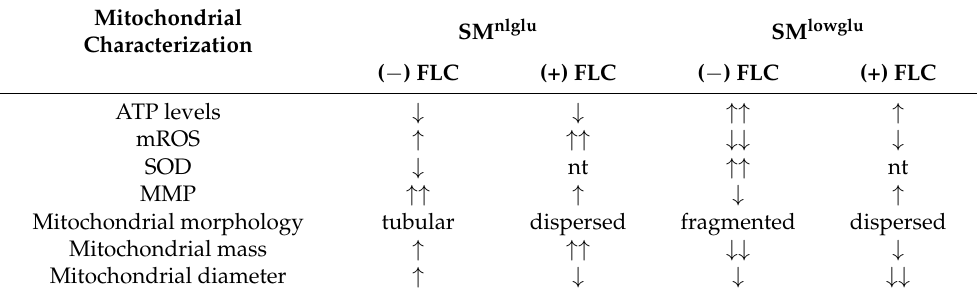
Figure 4. Low glucose induced mechanisms of FLC resistance. Low glucose (GLC) causes changes in the transcriptome, resulting in increased expression of genes encoding proteins for efflux, fatty acid oxidation, and superoxide dismutases (SOD). SODs inhibit ROS altering mitochondrial functions causing increased cellular ATP levels. Increased ATP levels can also be attributed to increased fatty acid oxidation. Increased ATP fuels the efflux pump causing increased FLC efflux resulting in increased FLC resistance. Table 4. Impact of glucose on mitochondrial characterization in the presence or absence of